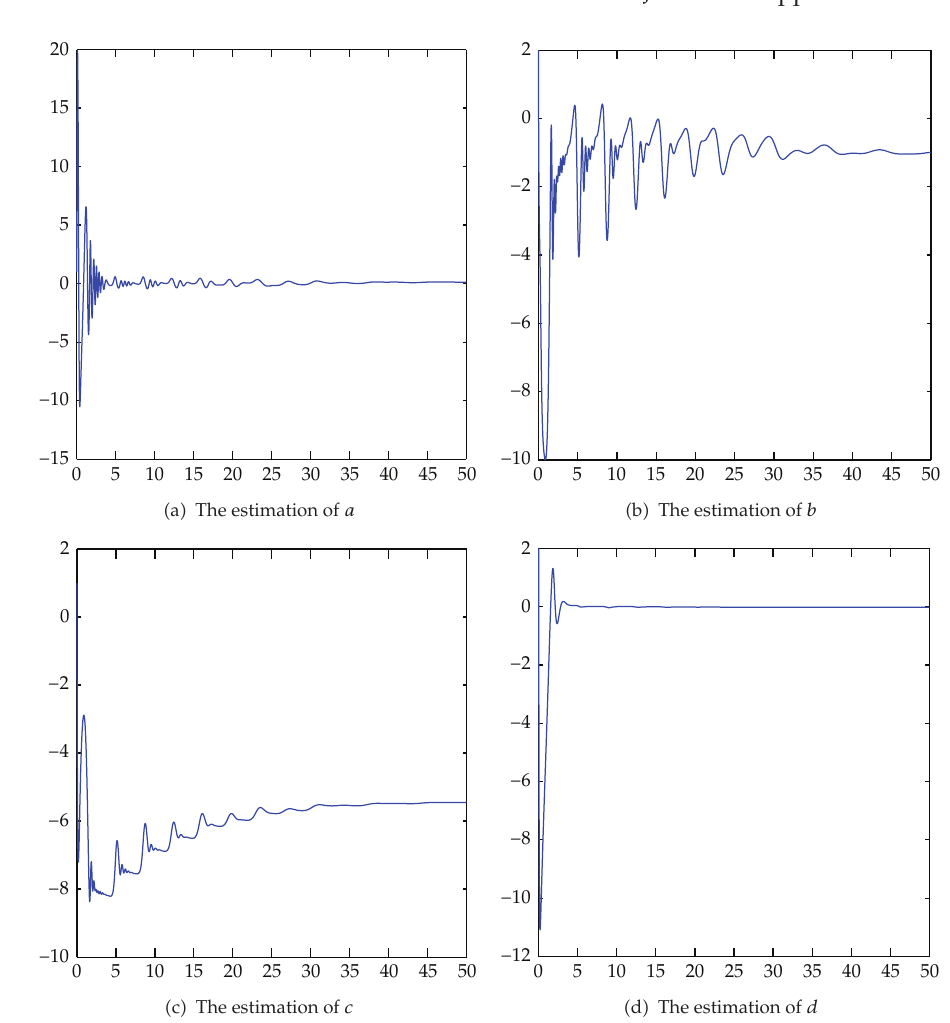
(cid:6) b is the estimation of